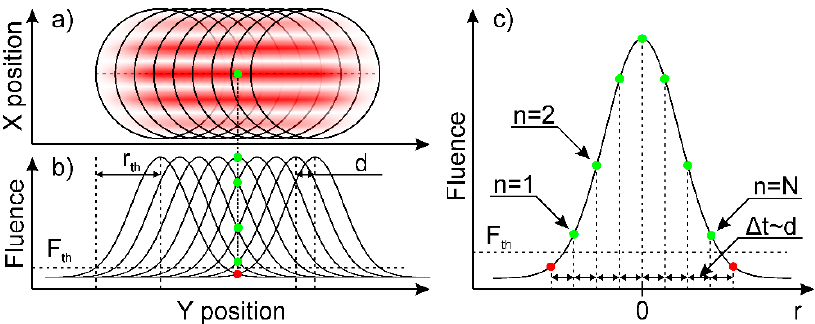
Figure 3. Representation of the analytical model used to calculate the depth of the DLIP-ablated line-like structure. ( a ) Graphical representation of the positions of the interfering laser spots during the scanning process. The green dot represents the position where the depth is calculated using the analytical model (point of interest). ( b ) Schematic representation of the fluence distribution of each laser spot along the center of the scanning path. Green and red dots represent the fluence, at which the point of interest was ablated with each passing pulse during laser scanning. ( c ) Laser spot center intensity profile along the scanning direction. The dots represent the laser fluence at which the point of interest was ablated by each forthcoming pulse. The green and red color of the dots corresponds to fluences higher and lower than the ablation threshold, respectively.